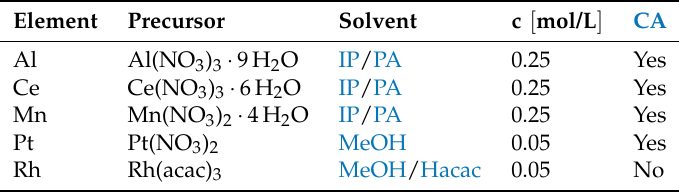
Table 6. Details about precursor solutions for sol-gel-synthesis.